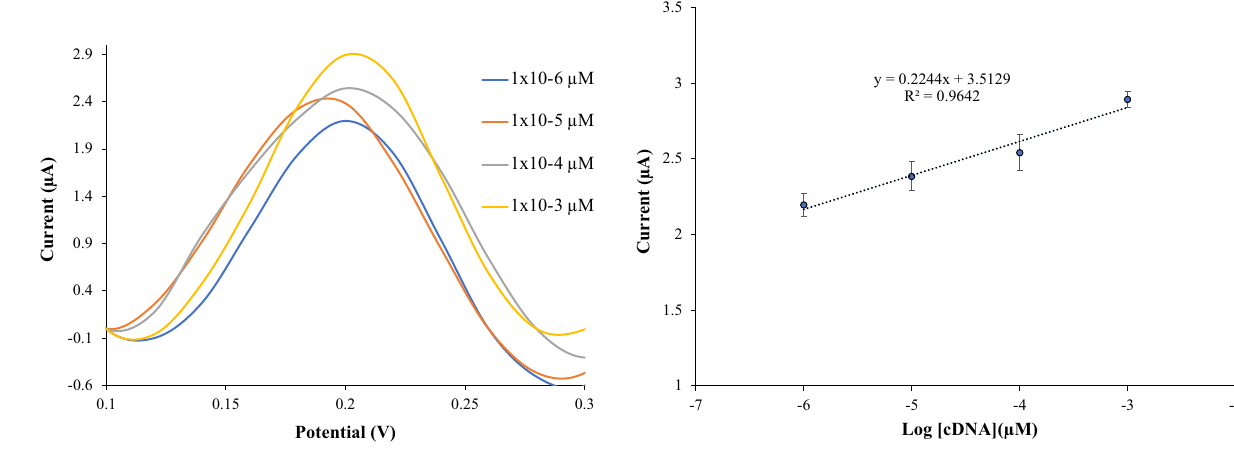
Figure 10. Linear response range for porcine DNA biosensor.